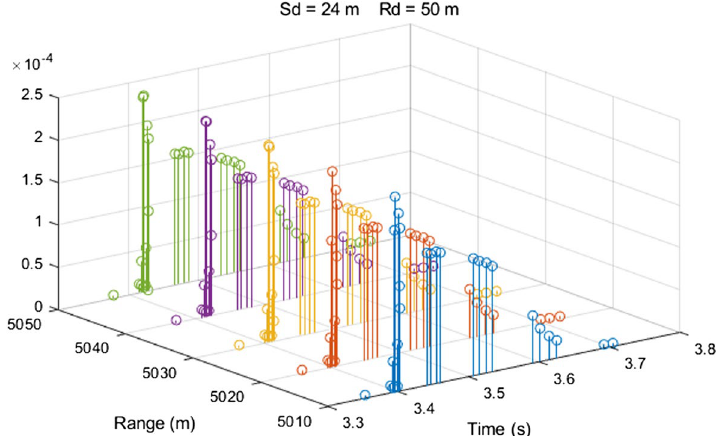
Fig. 8 The impulse response of hydrophone at different receiving points